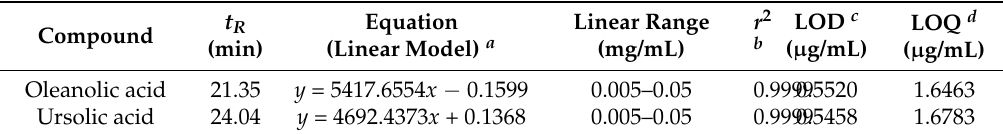
Table 2. Linearity, LOD, and LOQ of oleanolic acid and ursolic acid. Compound